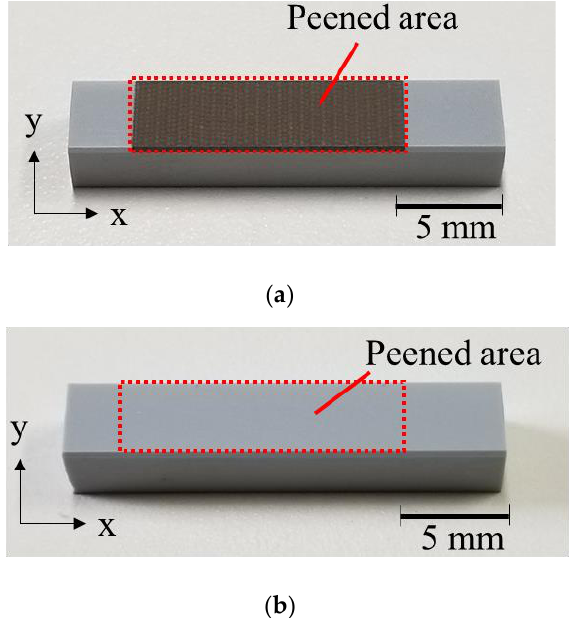
Figure 5. Photographs of LP specimens: ( a ) LPwC specimen (LPwC-1); ( b ) LPC specimen (LPC-1).